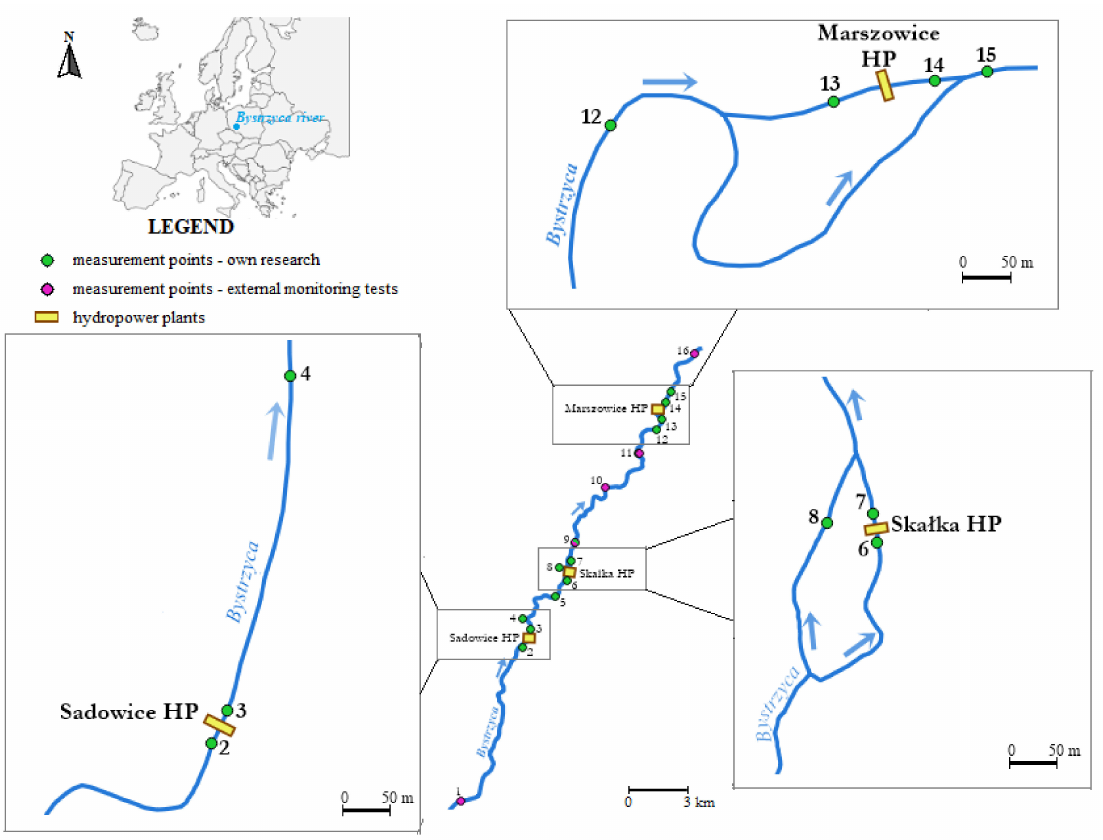
Figure 1. Location of research points and facilities, Bystrzyca River, Poland. Table 1. List of test points for physicochemical elements on the Bystrzyca River [81]. Point